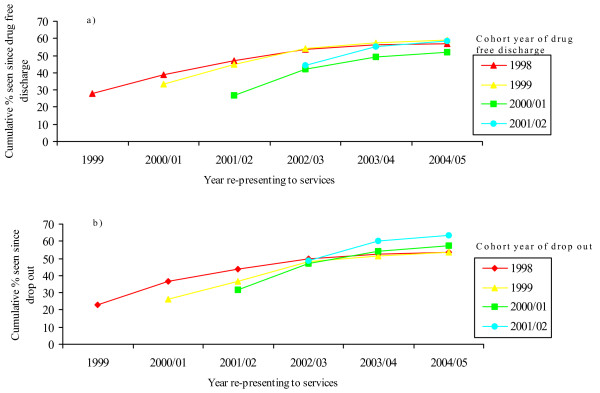
Cumulative re-presentation rates following drug free discharge (a) and drop out (b) from structured drug treatment service. Individuals presenting in each year of monitoring form each of the cohorts. Those discharged drug free (a) or dropping out (b) contribute to the cumulative re-presentation percentage in the first year they are seen again after leaving services. If they then leave services again they become part of a second cohort of discharge or drop out.